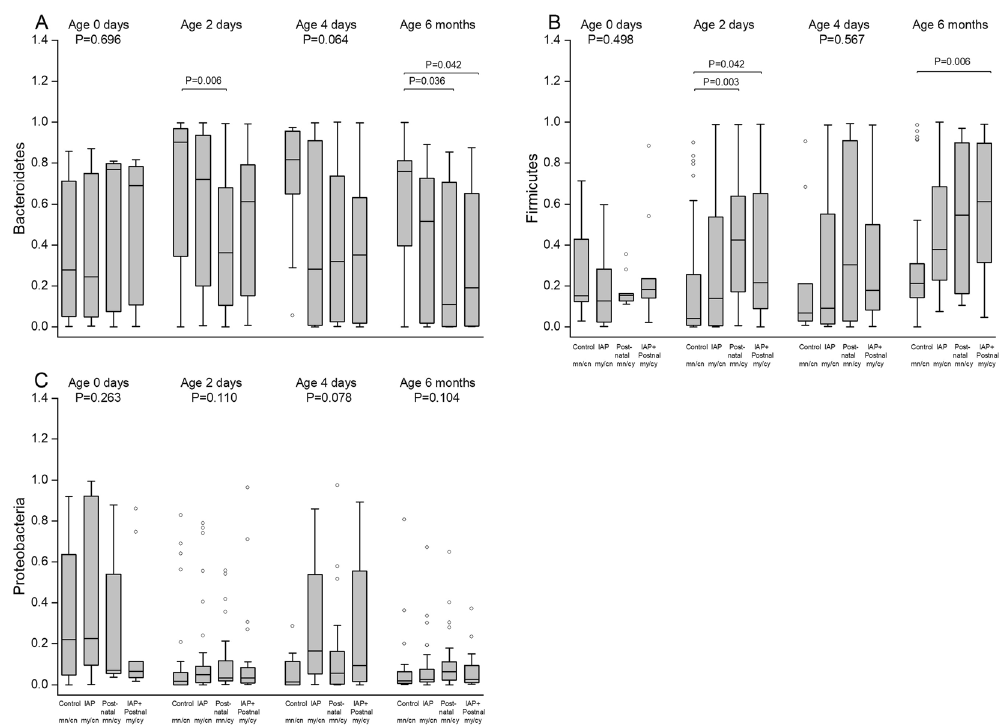
Figure 3. The relative abundances of three main bacterial phyla according to perinatal antibiotic exposure in infants: Bacteroidetes ( A ), Firmicutes ( B ), and Proteobacteria ( C ). The box-plots indicate the median value, interquartile range, and range in control (NN), IAP (YN), in postnatal (NY),and IAP + Postnatal groups (YY). At selected time points, the differences between groups were compared with Kruskal-Wallis test and if P < 0.05 with post hoc